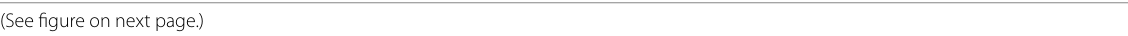
Portugal(See figure on next Fig. 2 Globuligerina waskowskae Gradstein nov. sp. Nos. 1a, b, c—holotype, sample 6, Morrisi Zone, Middle Bathonian, Gnaszyn, Poland; note microperforate wall with small, regularly distributed pustules, many with pore mounds. Nos. 2 and 3—paratypes, side and spiral views, same sample as holotype. No. 4 through 8—paratypes, same sample level as holotype. Nos. 9a, b— Conoglobuligerina helvetojurassica (Haeusler) with reticulate wall texture in sample 24—2, Tojeira Formation, Lower Kimmeridgian, Montejunto,